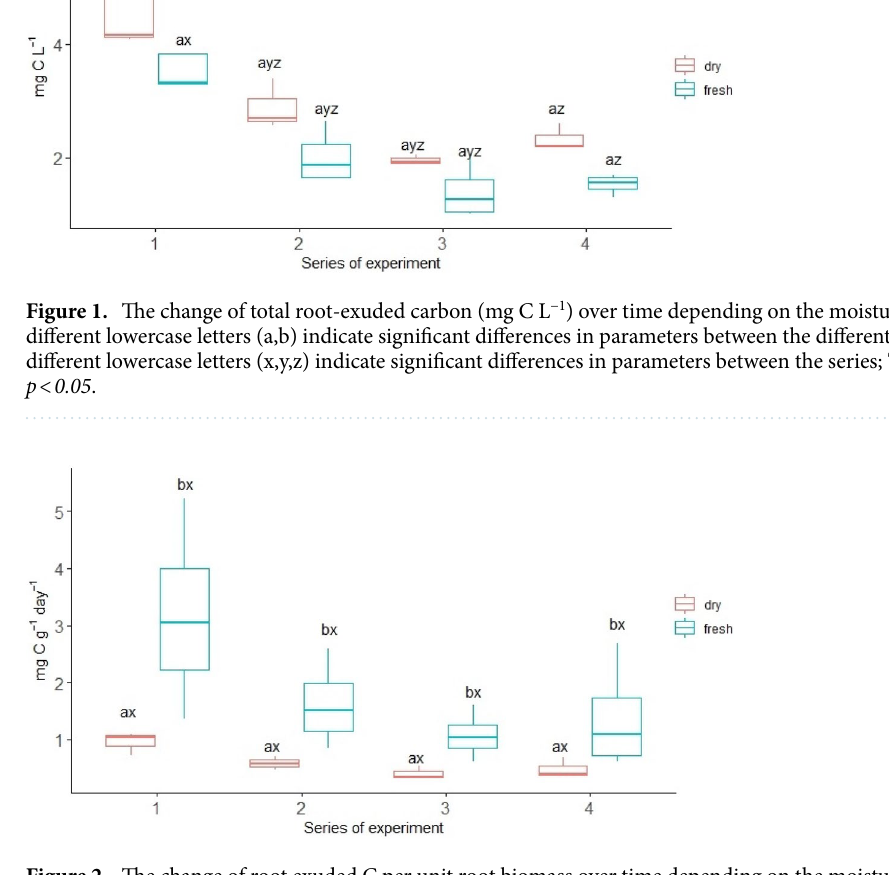
Figure 2. The change of root exuded C per unit root biomass over time depending on the moisture variant (mg C g -1 day -1 ); different lowercase letters (a,b) indicate significant differences in parameters between the different moistures; different lowercase letters (x,y,z) indicate significant differences in parameters between the series; Tukey HSD p < 0.05